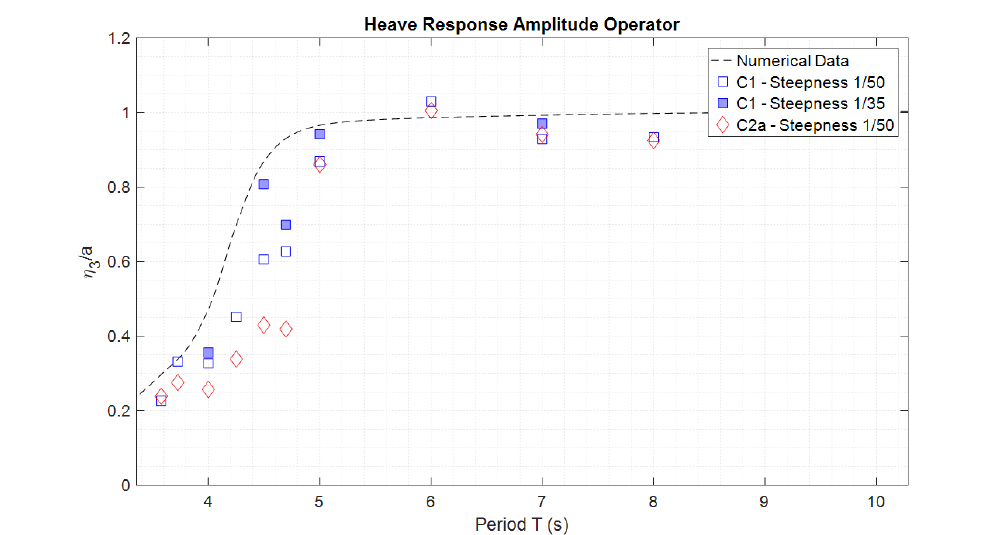
Figure 14. Experimental heave RAOs compared with the free-floating heave numerical RAOs.